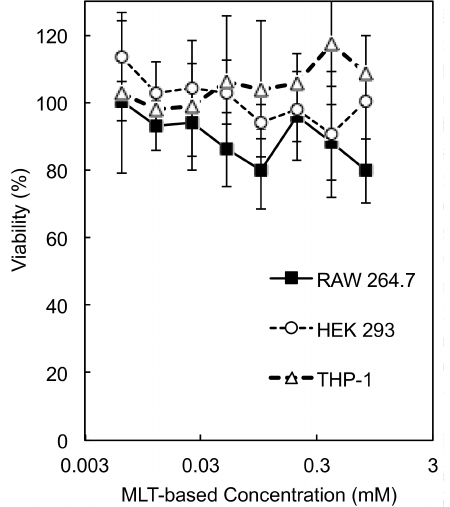
Figure 6. Cytotoxicity of MLT micelles against RAW 264.7 murine macrophages, HEK 293 human embryonic kidney cells and THP-1 human monocytes. Data shown as the mean ± S.D. ( n =